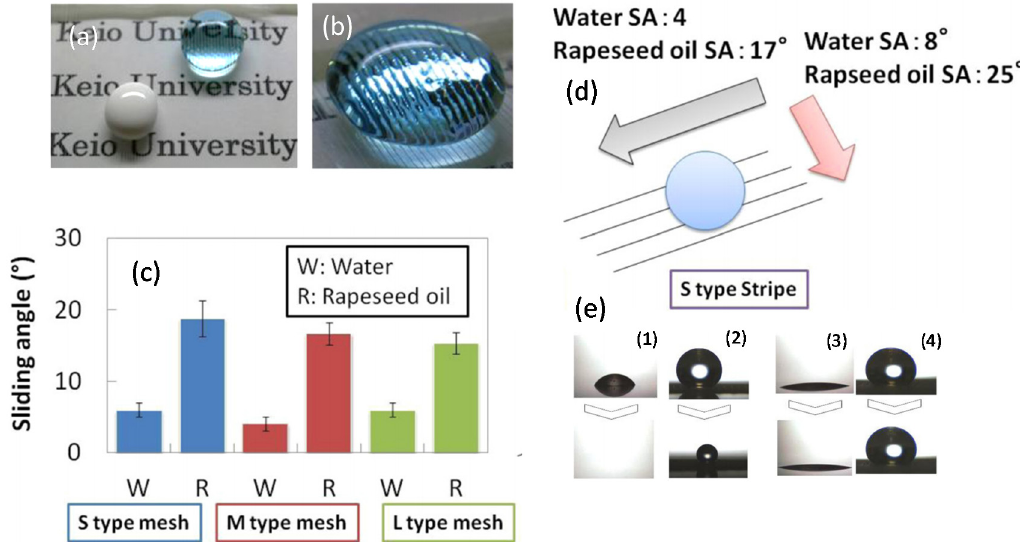
Figure 19. ( a ) Methylene blue ‐ stained water and white ink stained rapeseed oil on a stripe substrate and ( b ) enlarged stripe structure in the presence of water; ( c ) Sliding angle measurements; ( d ) The droplet of water or rapeseed oil was placed on the mesh/stripe substrate. The substrate was then tilted slowly and the angle was measured when the liquid moved. ( e ) Thermal stability of mesh and stripe substrates, examined at 80 °C for 10 min. (1)Water (10 μ L) on glass, the CA was 44°; (2) Water (10 μ L) on L ‐ type mesh, CA was changed from 151.6° to 146.0°; (3) Rapeseed oil (10 μ L) on glass, CA was changed from <5.0° to <5.0°; (4) Rapeseed oil (10 μ L) on L ‐ type mesh, CA was changed from 141.9° to 141.0° [47].